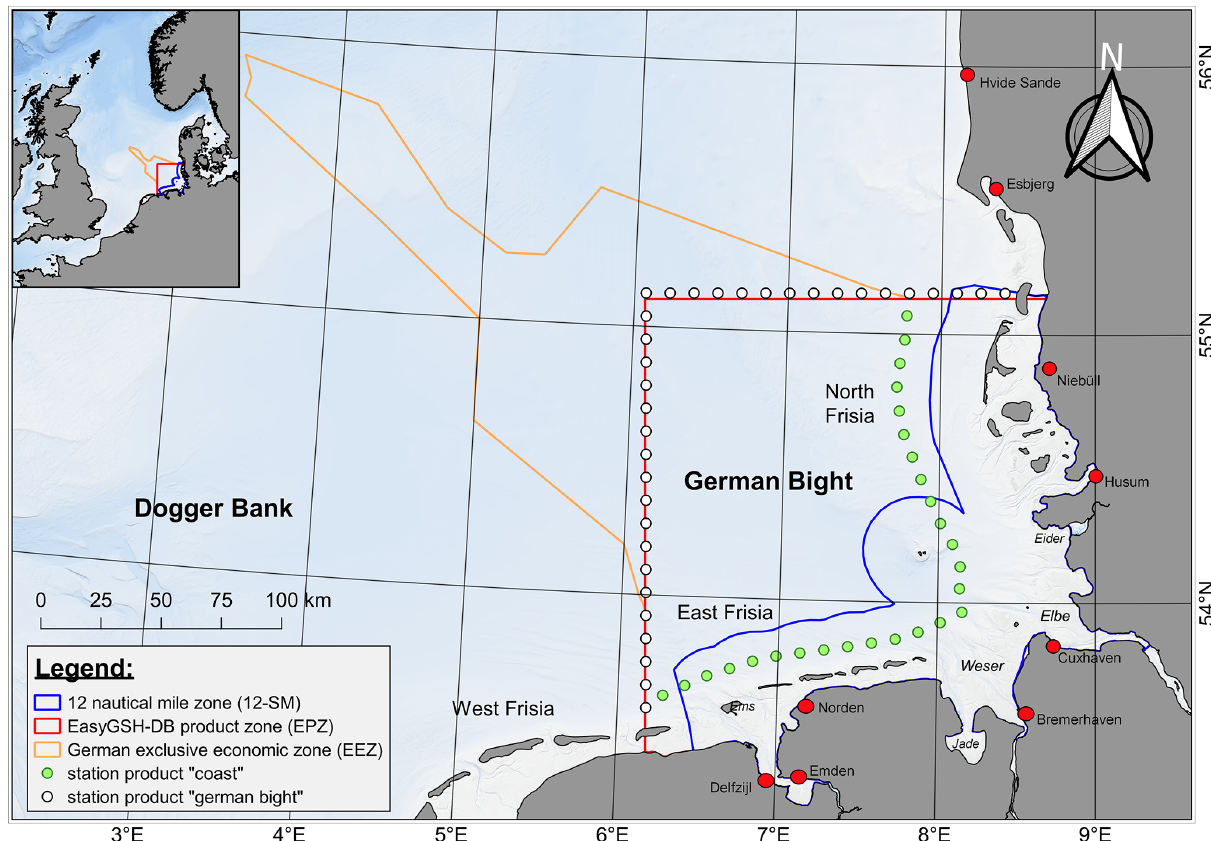
Figure 1. Data product zones in the data collection. The German 12-nautical-mile zone (12-SM) is shown in blue; the EasyGSH-DB product zone (EPZ) is shown in red; and the German Exclusive Economic Zone (EEZ) is shown in orange. Green and white dots represent wave spectra results near the coast and the EasyGSH-DB product zone (EPZ).